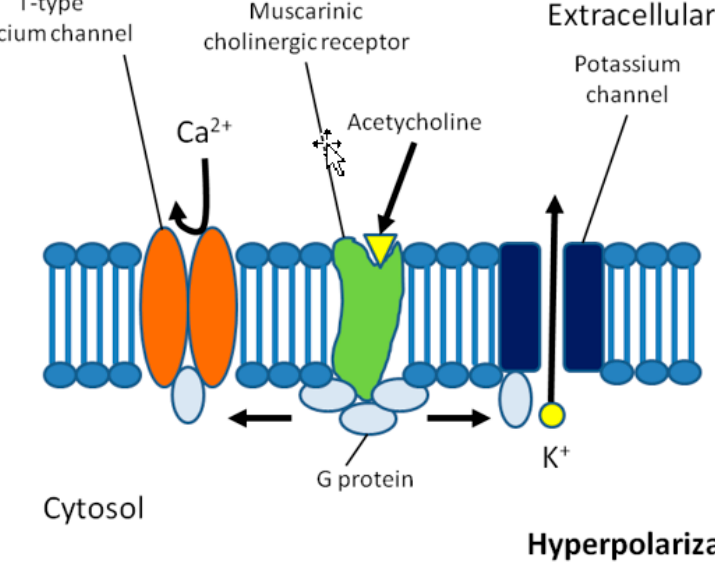
Figure 2. Potential role of the autonomous nervous system in the pathophysiology of atrial fibrillation. The cholinergic anti-inflammatory pathway, which is mediated by the parasympathetic nervous system via the vagus nerve, leads to secretion of acetylcholine, which binds to muscarinic cholinergic receptors. The receptors open potassium channels through stimulatory G proteins and close funny channels and T-type calcium channels through an inhibitory G protein. This leads to hyperpolarization, shorter duration of action potentials, a shortened effective refractory period, and a higher susceptibility to reentry at sites where acetylcholine is released in the atrium. The atria are only sparsely innervated by the sympathetic nervous system, which may also be activated during inflammation.